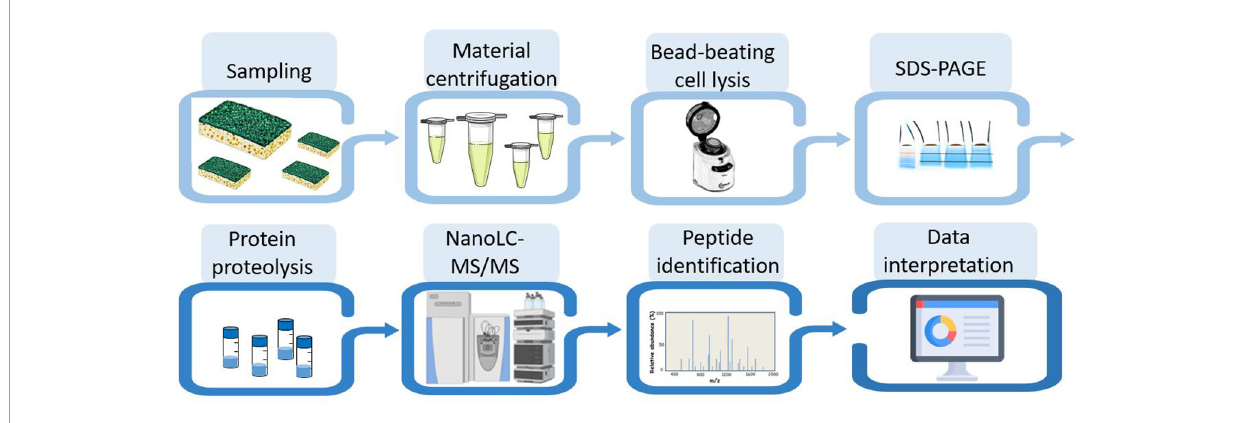
FIGURE2 Experimental workflow for metaproteomic analysis. The eight main steps applied to the four biofilm samples are symbolized.